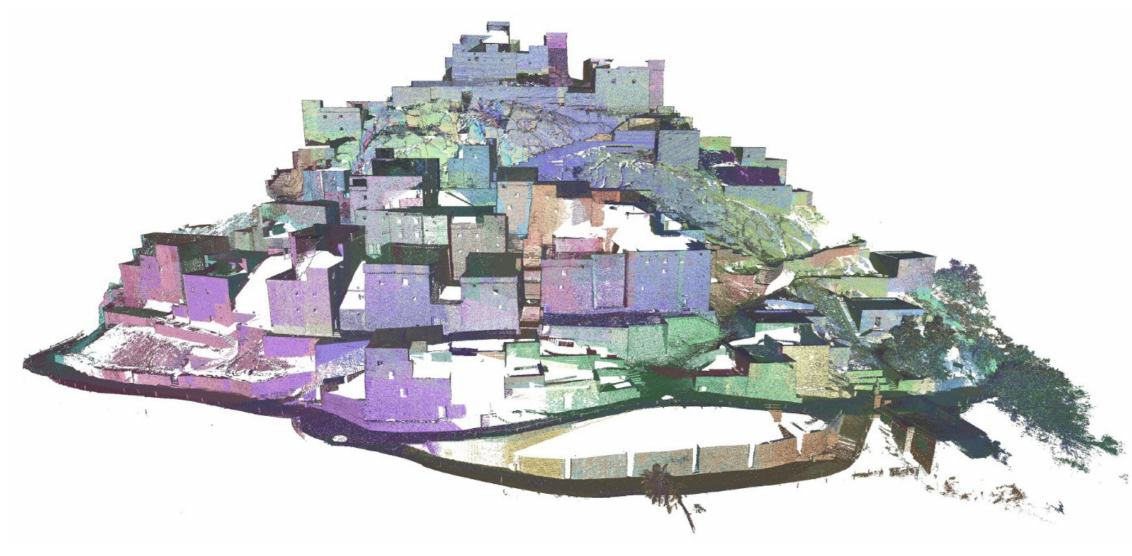
Figure 3. Scanning work plan.